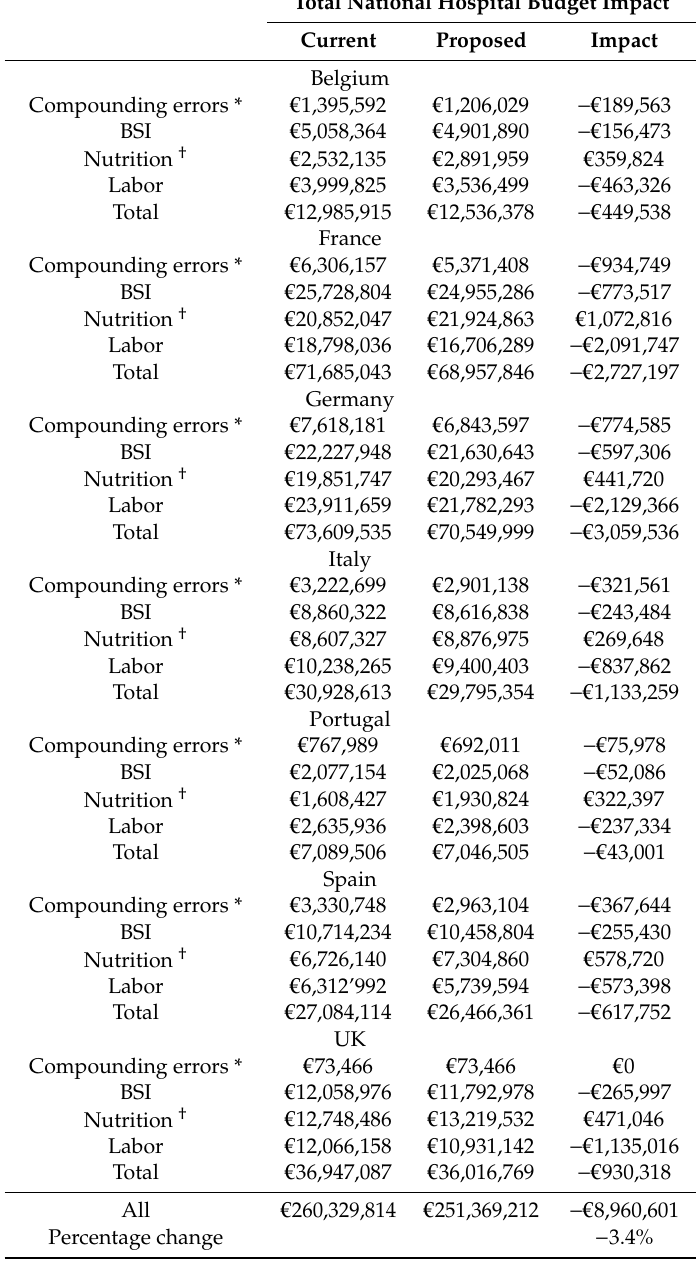
Table 4. Estimated total national hospital budget impact with a 10-percentage point increase in utilization of ready-to-use